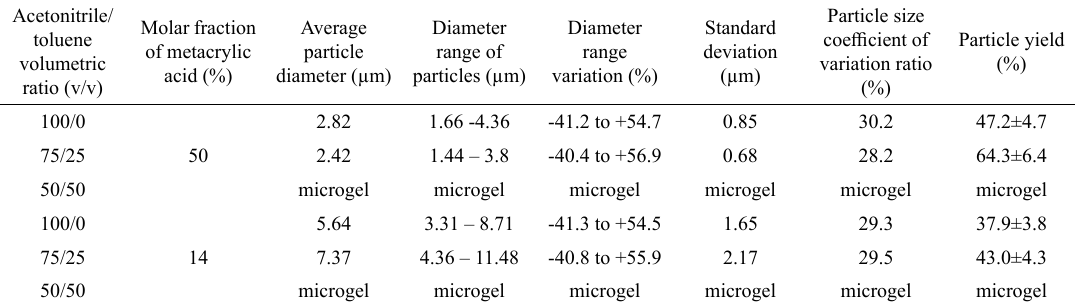
Table 5. Influence of the acetonitrile/toluene volumetric ratio on final polymer particles prepared with 14% and 50% MAA molar fraction, and 6.7 g / 100 mL ratio of total monomers/ diluents Acetonitrile/ toluene